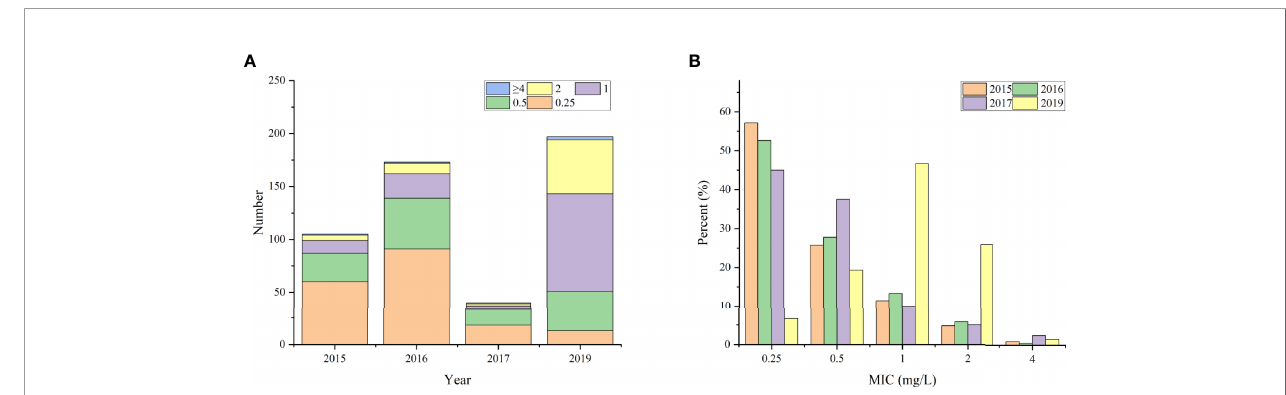
FIGURE 1 | The distribution of clinical isolates with different MIC values. (A) the total number; (B) the